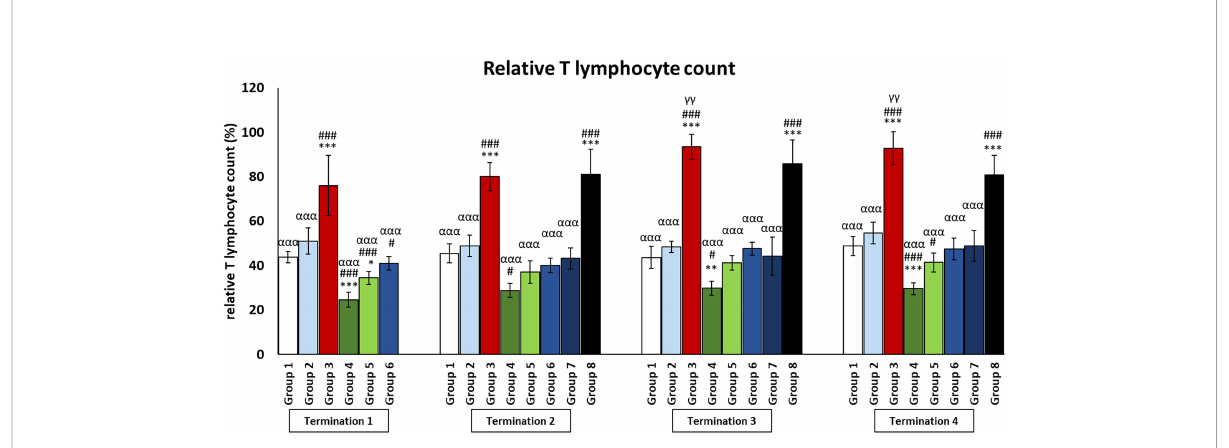
FIGURE 6 Changes in lymphocyte T counts in the blood of chickens receiving phage therapy or antibiotic therapy after 6, 20, 28, and 34 days of experiments. Results are presented as mean values ± SD. Statistical analyses were performed by Kruskal – Wallis test and post-hoc Dunn test or ANOVA and post-hoc Tukey ’ s test. The signi fi cance of differences between controls and particular treated groups is observed and marked by the following: asterisks (*) vs. saline control; (#) vs. phage control (group 2); (a) vs. infected control (group 3); (g) vs. termination 2. p < 0.001 (***, ###, aaa ), p < 0.01 (**, gg ), and p < 0.05 (*,